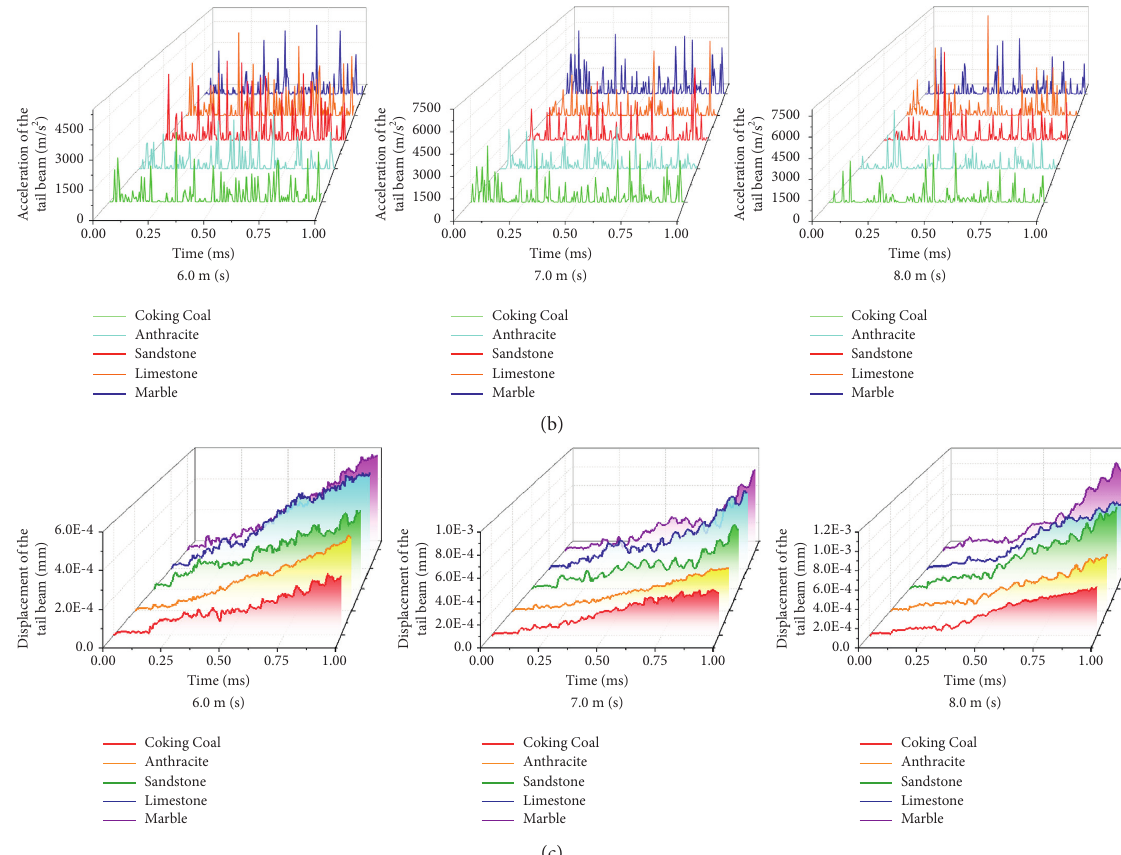
Figure 18: Simulation data of tail beam. (a) Speed vibration signals of tail beam. (b) Acceleration vibration signals of tail beam. (c) Displacement vibration signals of tail